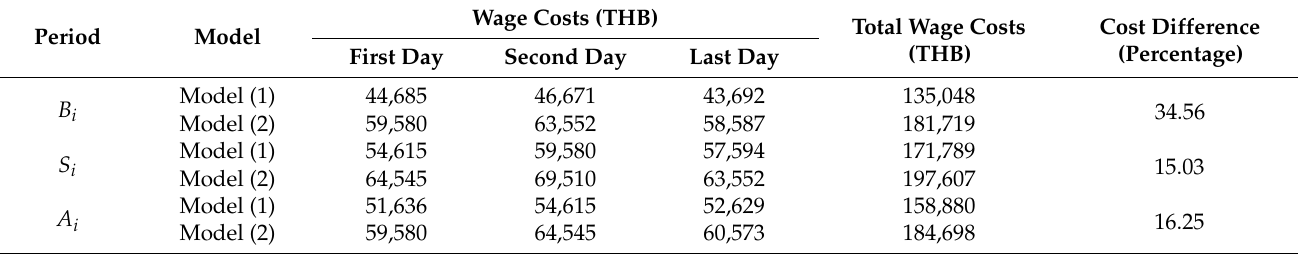
Table 10. Wage costs of the three periods for the two